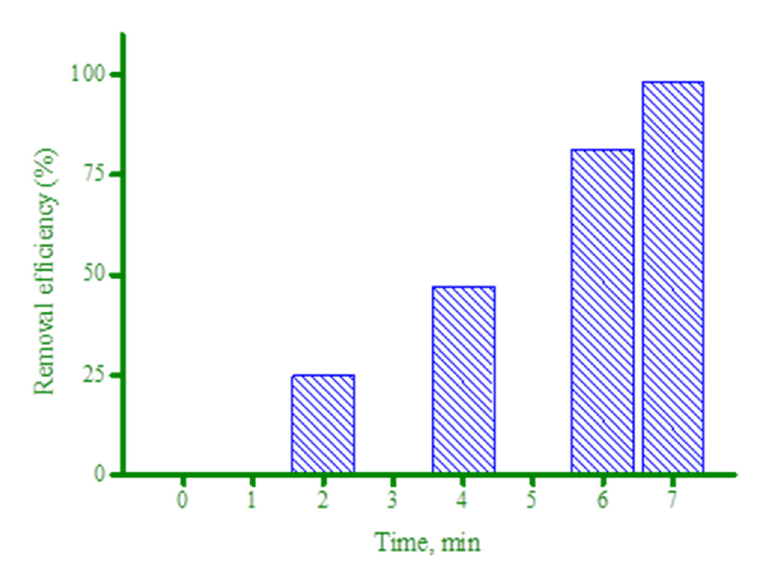
Figure 14. Removal efficiency (%) of MV (1 mg in 100 mL of deionized water) using 40 mg of the synthesized CrFeO 3 -CNT adsorbent at different contact times. synthesized CrFeO 3 -CNT adsorbent at different contact